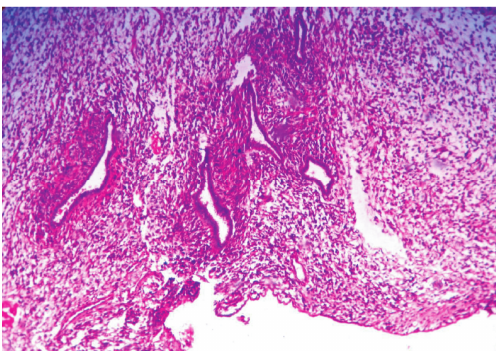
Figure 3: Photomicrograph showing condensation of hypercellular stroma forming periglandular cu ff s around glandular slit-like spaces (H&E stain, × 200).